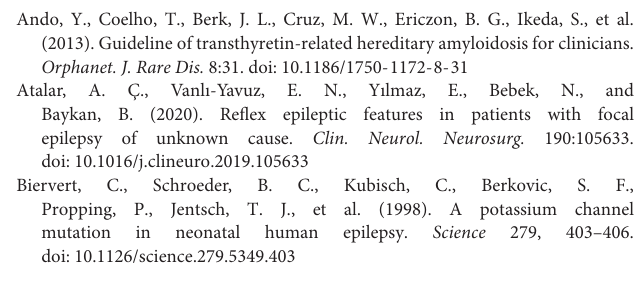
Supplementary Figure 1 | Distribution of compensation coefficient for differentially expressed genes in the KM and W rats. The histogram shows the compensation coefficients for expression changes in the “0” rats. Density distribution was estimated using kernel density estimation (KDE). The compensation coefficient was calculated as a percentage of mean (logCPM) KM – mean (logCPM) 0)/(mean (logCPM) KM – mean (logCPM) W. Supplementary Figure 2 | The expression of genes involved in the oxidative phosphorylation pathway was partly attenuated in the “0” rats. (A) Differential expression of genes participating in the oxidative phosphorylation pathway (KEGG rno00190). The illustration of the pathway is shown with slight modifications. Gene expression changes are shown in color (log2-scale; LogFC; red – upregulation, blue – downregulation, gray – no change, white background – the absence of expression). Each gene block is divided into two sections (the left block shows differentially expressed genes in the KM and W rat samples; the right block shows the differentially expressed genes in the “0” and KM rat samples). (B) Scatter plot depicting the pairwise comparison of log2-fold changes between the KM vs W rat and “0” vs KM rat groups. R – Spearman’s correlation coefficient. Supplementary Table 1 | Primers for Q-RT-PCR used in the work. Supplementary Table 2 | Differentially expressed genes (DEG) between all groups of